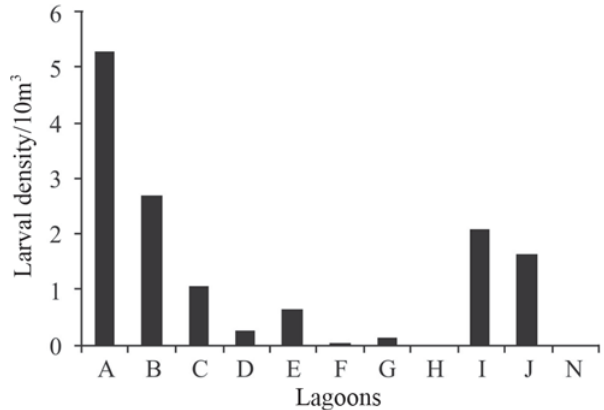
Fig. 2. Spatial distribution of fish larvae in marginal lagoons along the Cuiabá River in December 2006.